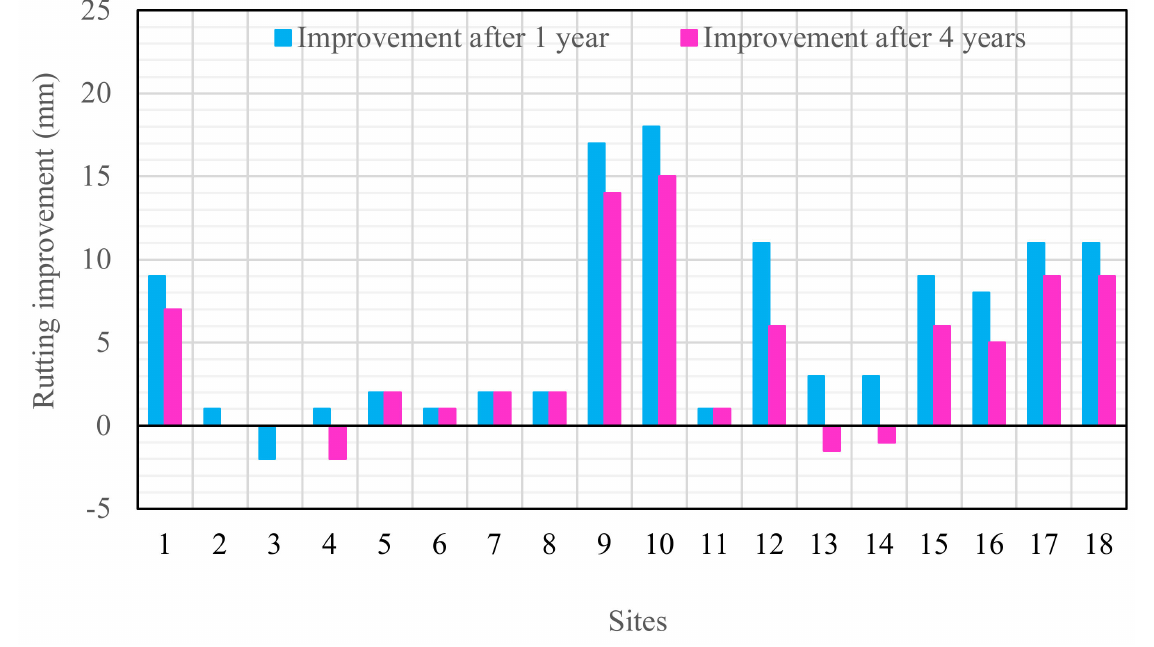
Figure 2. Effectiveness of WMA overlay containing RAP on rutting improvement at different sites with dry climatic conditions.